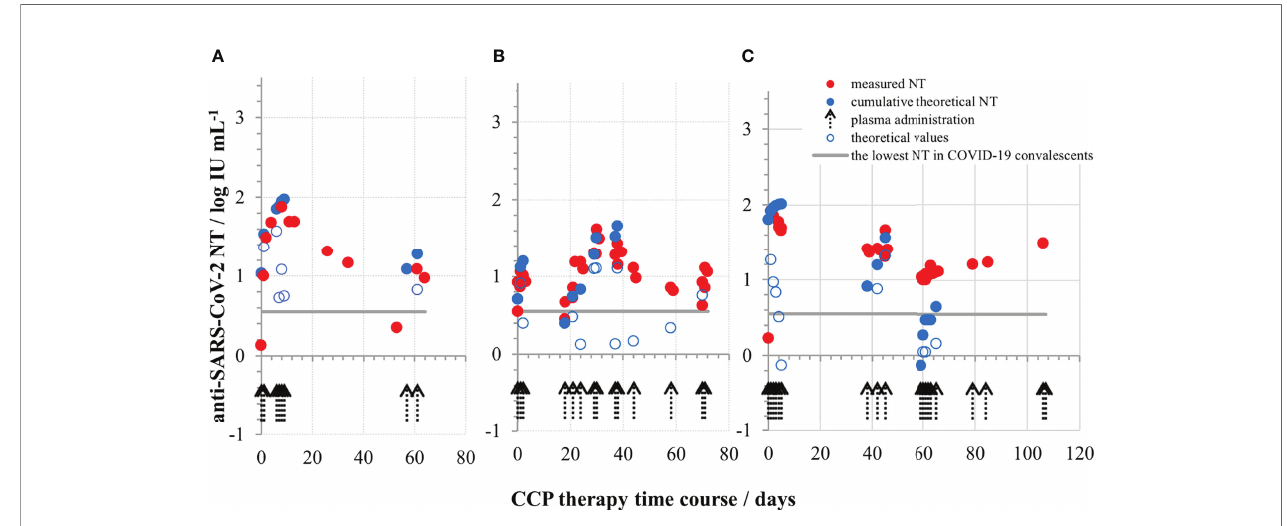
FIGURE 6 | Neutralising SARS-CoV-2 antibody titres (in IU mL -1 ) during COVID-19 convalescent plasma therapy in the fi rst (A) , second (B) and the third (C) representative COVID-19 patient, all three completely lacking their own immunoglobulins due to the underlying haematological malignancy and its treatment. The quantities of measured NAbs were above the lowest NT detected in successfully recovered